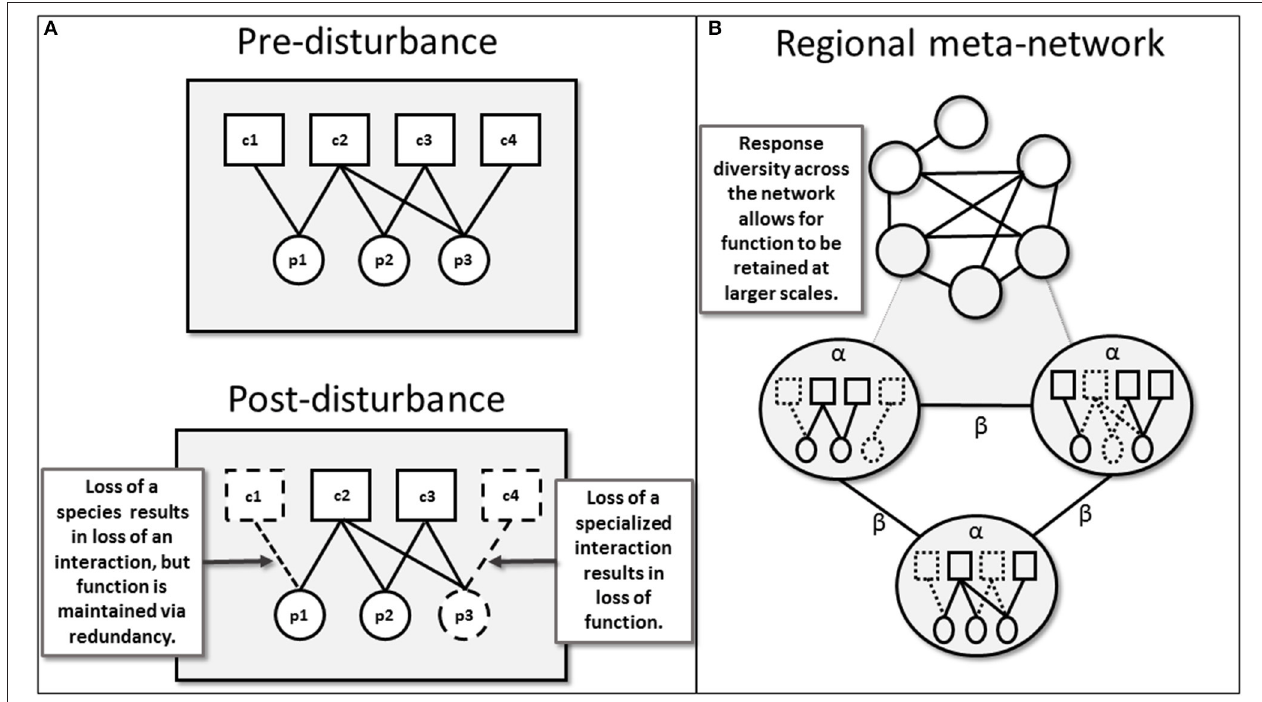
FIGURE 1 | (A) Pre-disturbance and post-disturbance metawebs, displaying the full regional pool of species and potential interactions. Here nodes represent individual species of primary producers (circles) and herbivores (squares), while edges (links) represent interactions between species. Post-disturbance, the loss of species and interactions are indicated by dashed edges. In this case the loss of a single species (c1) also results in the loss of an interaction, however ecological function (i.e., nutrient cycling via consumption of this plant species) is maintained as a redundant interaction occurs with another herbivore species (c2). Conversely, the loss of a specialized interaction may result in the loss of ecological function. In this example, the interaction between a plant (p3) and herbivore (c4) no longer occurs, reducing functional diversity and eventual loss of partner species (p3-c4). (B) The regional meta-network, for which nodes represent plots and edges represent shared interactions between plots. Three plots are enlarged so that we may examine the corresponding local networks of interactions. While α -diversity of species and interactions are calculated within each plot, β -diversity is calculated between plots. Focusing in on shared interactions between three individual plots illustrates the turnover of interactions between local plots (high β -diversity), this β -diversity summarizes variation in post-disturbance responses, which provides ecological